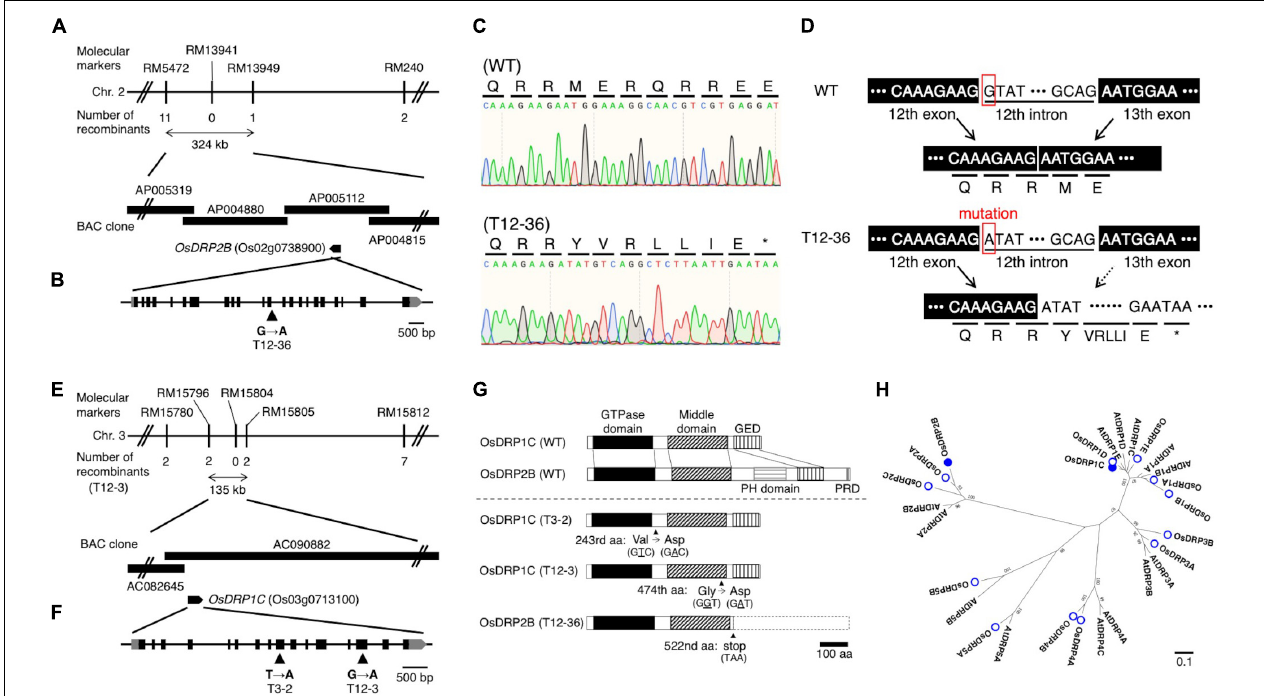
FIGURE 2 | Map-based cloning of the causative genes of the mutants. (A,E) Linkage and physical map of the causative gene locus in (A) T12-36 and (E) T12-3. The vertical bars represent molecular markers, and the numbers of recombinant plants are indicated below the linkage map. (B,F) Structure of (B) OsDRP2B (Os02g0738900) and (F) OsDRP1C (Os03g0713100). Black and gray boxes indicate exons and untranslated regions (UTRs), respectively. Single nucleotide mutation at position (B) 4,537 bp of OsDRP2B and (F) 2,708 bp (T3-2) and 4,314 bp (T12-3) of OsDRP1C in the open reading frame (ORF) (indicated by arrowheads). (C) Sanger sequencing analysis around the splicing junction of 12th intron in OsDRP2B cDNA in the wild-type (WT) and T12-36. (D) OsDRP2B mRNA structures and amino acid sequences in WT and T12-36 mutant. (G) Domain structure of OsDRP1C and OsDRP2B in WT and the mutants. GED, GTPase-effector domain. PH, Pleckstrin homology. PRD, Proline-rich domain. (H) Phylogenetic tree constructed using the full-length amino acid sequences of DRP family proteins in rice and Arabidopsis using MEGA7. Numbers on branches are the 1,000-bootstrap values. Rice DRP proteins, open circles; proteins encoded by the causative genes of mutants, filled circles. Accession numbers of proteins are in Supplementary Table 3